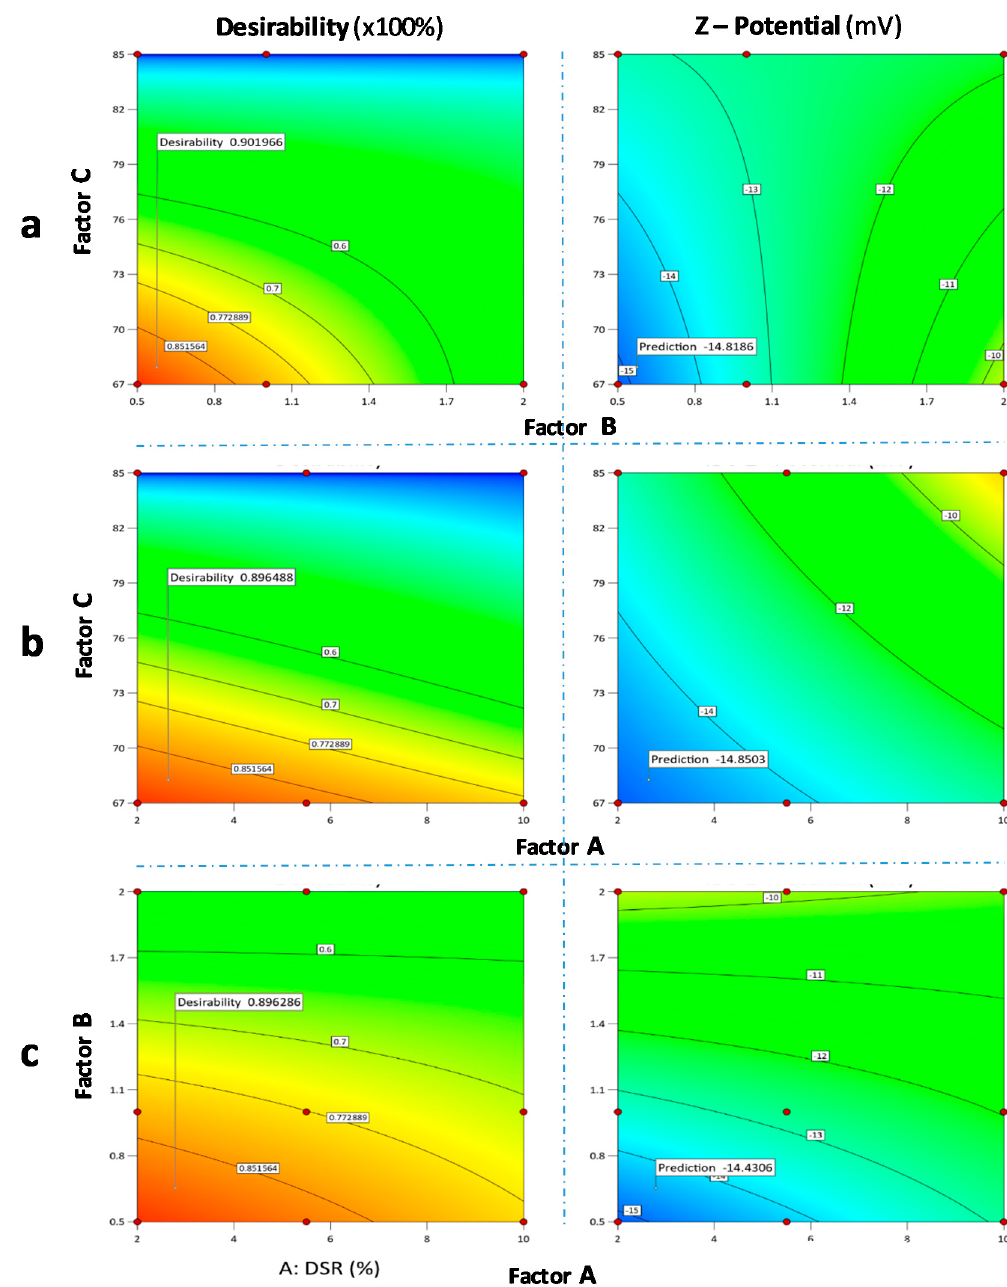
Figure 8. Contour plots of the desirability function used to explore the factor interaction space of: ( a ) inlet temperature and drug-mannitol ratio, ( b ) inlet temperature and drug-stabilizer ratio, and ( c ) drug-stabilizer ratio and drug-mannitol ratio. For each graph on the left column, one random yet correlated to the optimum individual ζ -potential response, is flagged. Red to orange contours converge to the operational area of interest. For each graph on the right column, the optimum respective individual ζ -potential response is flagged. Shades of blue contours converge to the operational area of interest of the selected displayed factors.